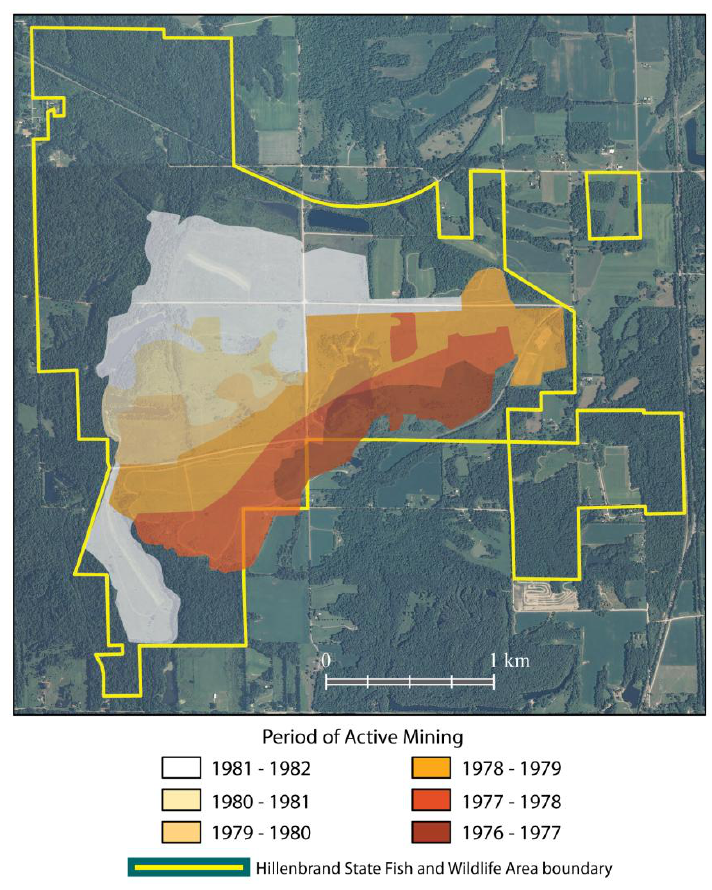
Figure 2. Pattern of coal mining in the Hillenbrand study